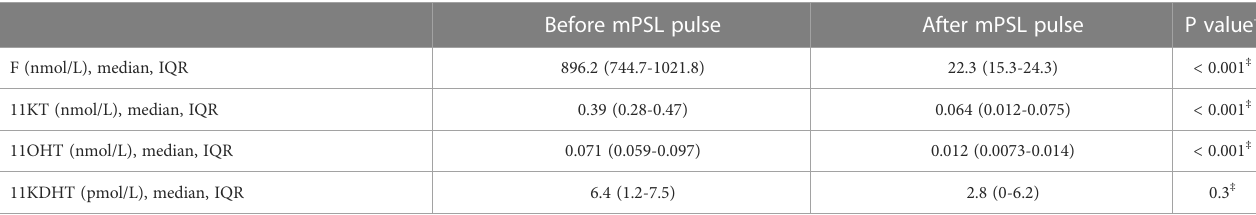
TABLE 2 Steroid hormone values before and after mPSL pulse (Study 1).